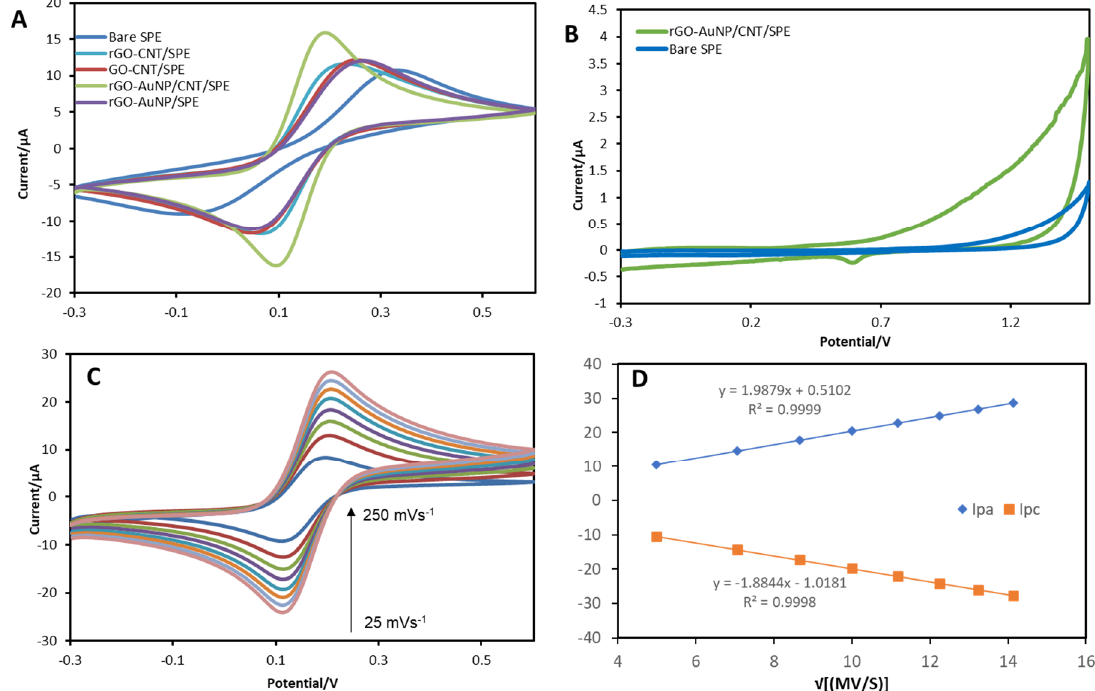
Figure 4. ( A ) CV of (a) bare SPE, rGO-CNT/SPE, GO-CNT/SPE, rGO-AuNPs/CNT/SPE, and rGO- AuNP immersed in 0.1 M KCl containing 5 mM [Fe(CN) 6 ] −3/−4 . ( B ) Cyclic voltammograms of bare SPE (blue) and rGO-AuNPs-CNT/SPE (green) in a 0.5 M H 2 SO 4 solution. Scan rate: 50 mVs −1 . At 100 mVs −1 scan rate: ( C ) CVs of rGO-AuNPs/CNT/SPE at different scan rates (25–250 mVs -1 ) in 0.1 M KCl containing 5 mM [Fe(CN) 6 ] −3/−4 . ( D ) Plots of anodic current peak vs. square root of scan rate and cathodic current peak vs. square root of scan